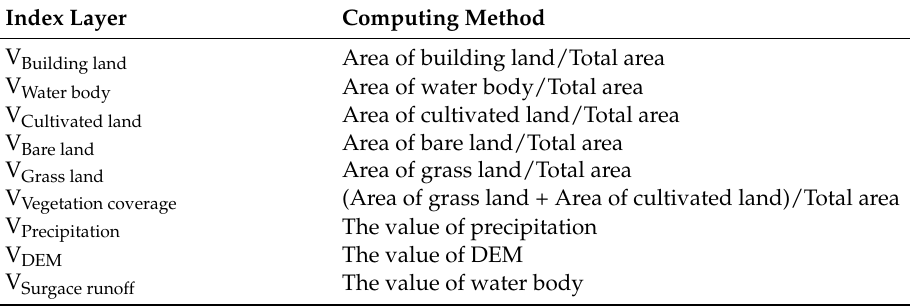
Table 3. Computing methods of all indicators in index